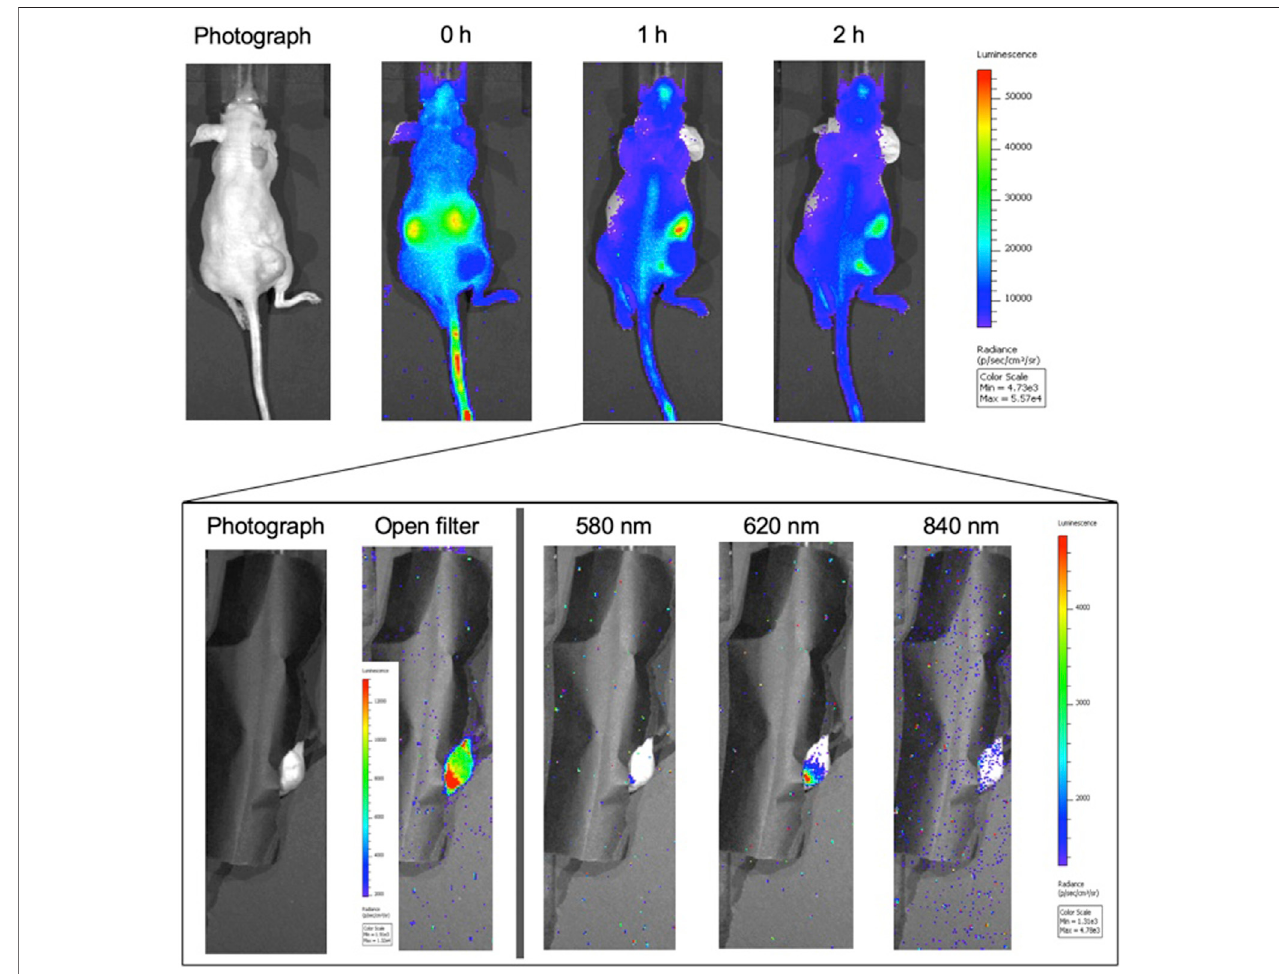
FIGURE4| Cerenkovimagingtimecourseof 18 F-DFRAintumor-bearingathymicnudemice( n (cid:2) 1):Amousewitha4175-Luc+breasttumorxenograftintheright fl ank was injected with 22.2 MBq of 18 F-DFRAvia tail vein and imaged for 2 h. (A) The top fi gure shows the biodistribution ofthe probe inthe mouse at three time points using the open fi lter setting in the IVIS Spectrum. The kidney signal is quite prominent at t (cid:2) 0 h, suggesting rapid renal elimination. (B) At the 1 h time point, the mouse was covered leaving only the tumor visible for imaging (inset). The open fi lter image shows that the probe was in higher concentration in the periphery in the lower part of the tumor (smaller lobe). Imaging with the 580 nm fi lter showed little signal emitting from this lobe; the signal was higher in the 620 nm fi lter, indicating probe reduction.